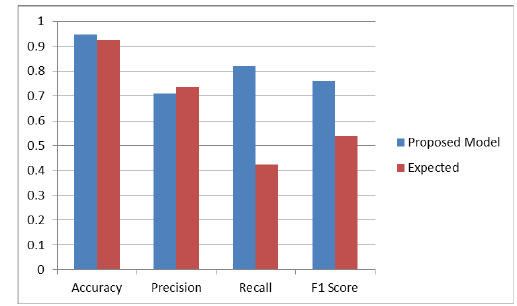
Figure 7. Comparison of expected and proposed